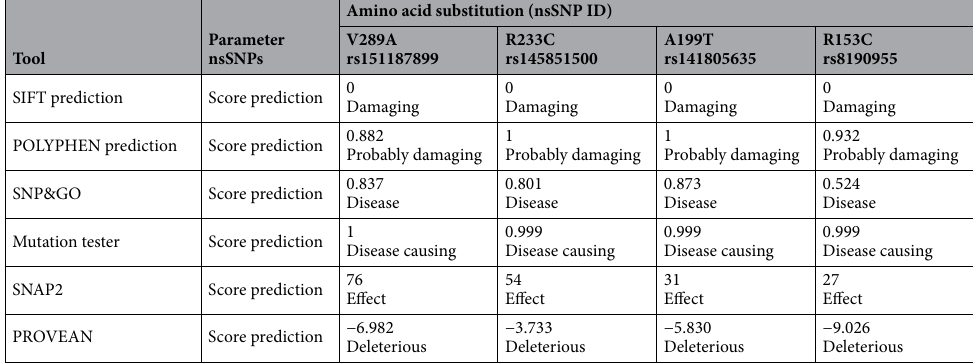
Table 1. The list of deleterious nsSNPs predicted by SIFT, SNAP2, POLYPHEN, SNP&GO, Mutation tester, Provean and SNAP2 tools.